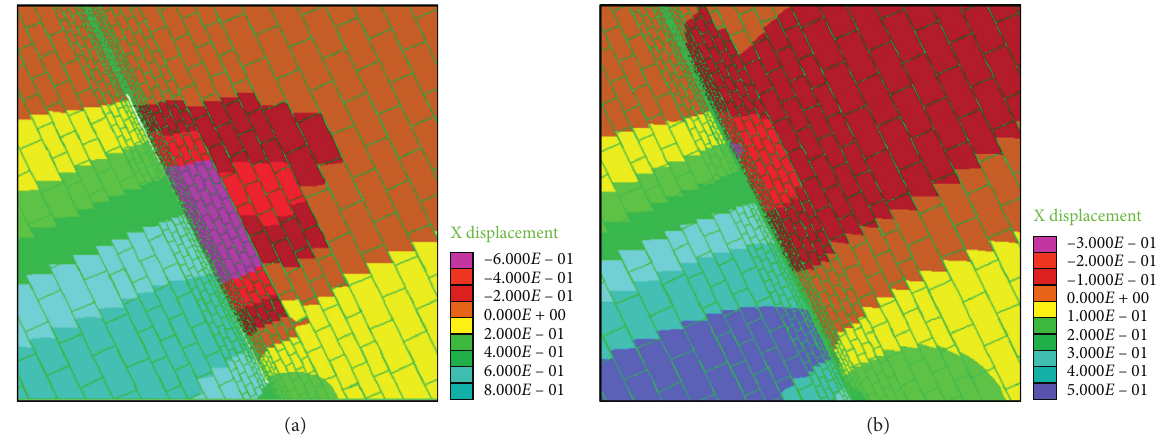
Figure 6: Horizontal displacement contours of surrounding rock with 200m stope height. (a) Caving. (b) Backfilling.